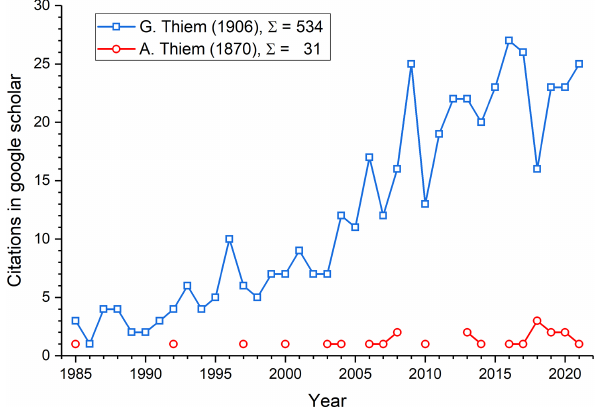
Figure 15. Citations of the two seminal papers by Adolf and Gün- ther Thiem (Thiem, 1870, 1906), according to Google Scholar (https://scholar.google.com/, last access: 17 May